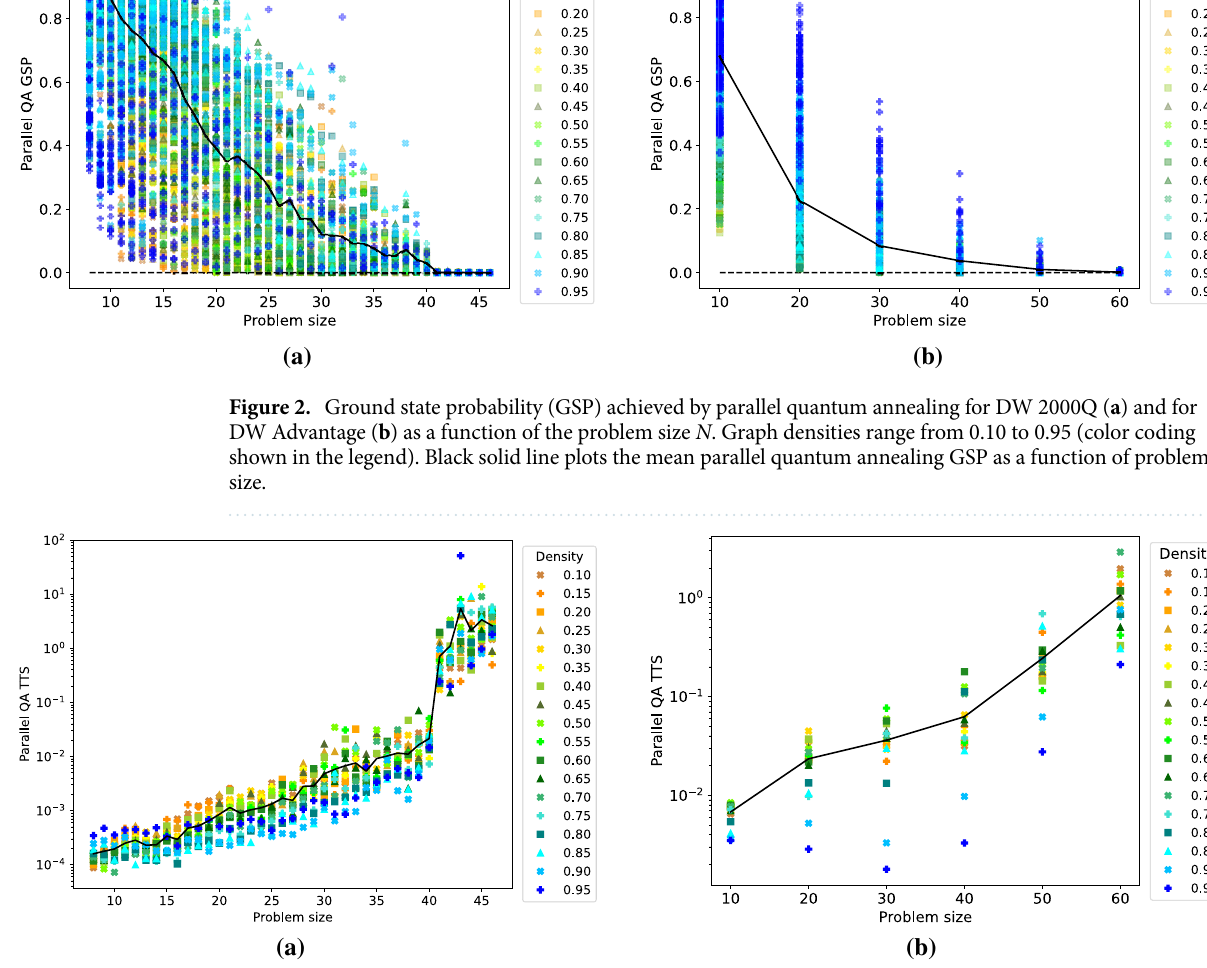
Figure 3. Ensemble TTS for parallel quantum annealing as a function of the problem size for DW 2000Q ( a ) and DW Advantage ( b ). Graph densities range from 0.10 to 0.95 (color coding shown in the legend). Black solid line plots the mean parallel quantum annealing ensemble TTS as a function of problem